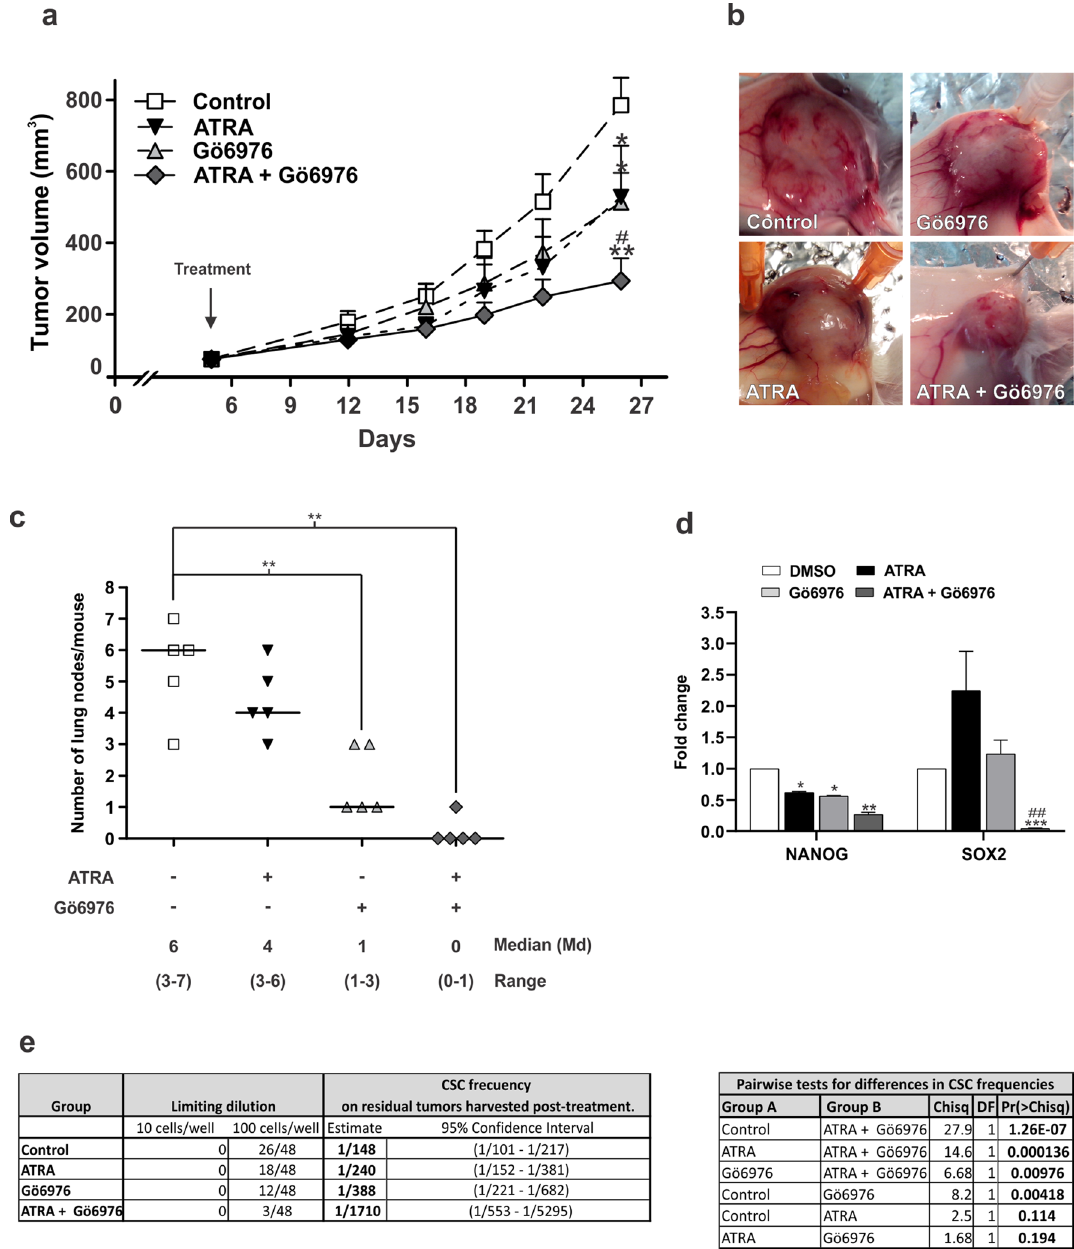
Figure 6. Evaluation of tumor growth, metastatic dissemination and cancer stem cell frequency. ( a ) LM38-LP cells were harvested from subconfluent monolayers and orthotopically inoculated into the fat pad of BALB/c mice. Five days later, animals receive the different treatments that consist in a silastic pellet containing ATRA (10 mg) or an empty pellet as control. Mice additionally received a peritumoral injection of Gö6976 (0.2 mg/ kg) in physiological solution or physiological solution as control. Size of the two perpendicular diameters was recorded and used to calculate tumor volume. Each data point represents mean ± S.D. (n = 5), * p < 0.05 versus control, ** p < 0.01 versus control, # p < 0.05 versus Gö6976 (ANOVA test). Two independent experiments were performed with similar results. ( b ) Representative photographs of LM38-LP tumors at necropsy are shown. ( c ) The number and size of surface lung nodules was determined under a dissecting microscope. Each data point represents the number of lung nodules per animal. Median and range are indicated in each experimental group. ** p < 0.01 versus control (Kruskall-Wallis test). Figure shows the results of one experiment representative of three independent assays. ( d ) RNA from LM38-LP tumors harvested post-treatment was isolated. Nanog and Sox2 expression was analyzed by RT-qPCR. The fold of change of mRNA levels was calculated using the ΔΔCt method with GAPDH used as an internal control. Histograms represent mean ± S.D. * p < 0.05 versus control, ** p < 0.01 versus control, *** p < 0.001 versus control, ## p < 0.01 versus Gö6976 (ANOVA test). Three independent experiments were performed. ( e ) CSC frequency estimates and p values calculated by using the ELDA software are